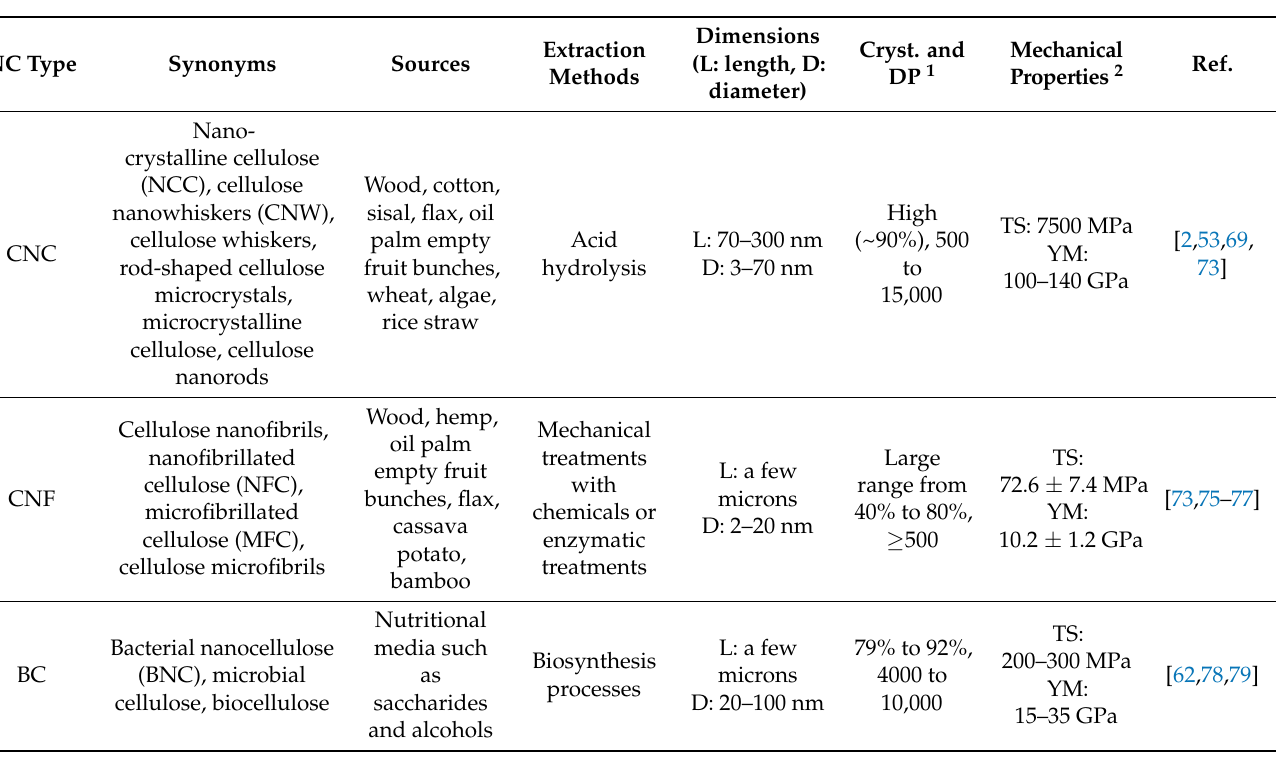
Table 3. Comparison between general types of